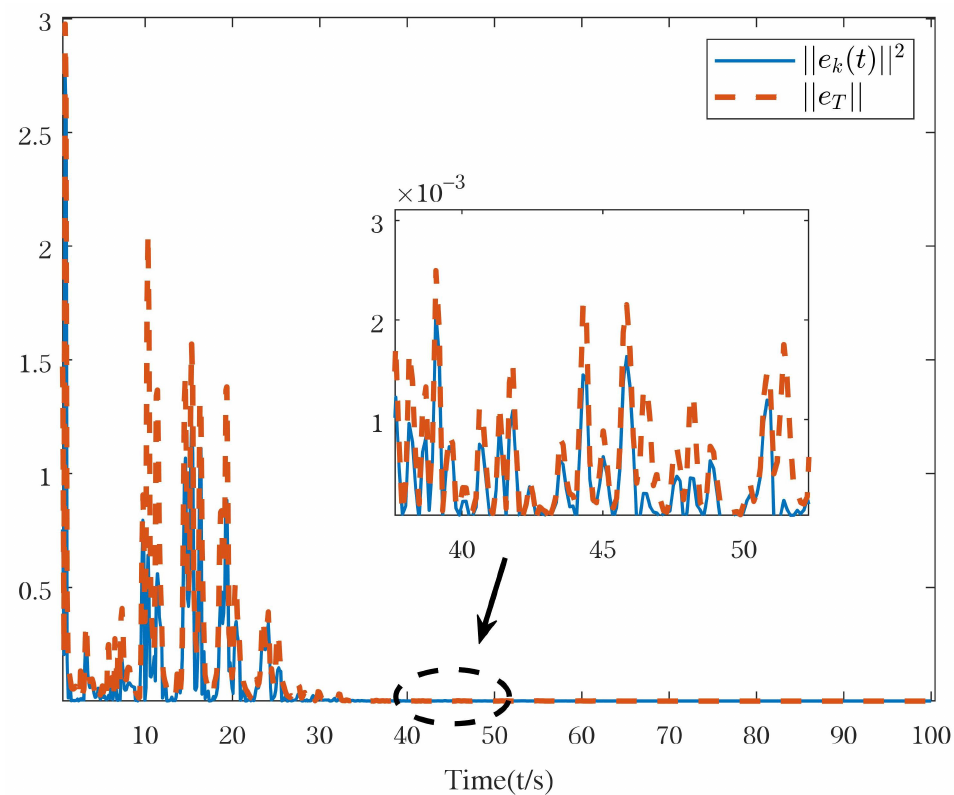
Figure 10. The event error (cid:107) e k (cid:107) 2 and the triggering threshold e T .